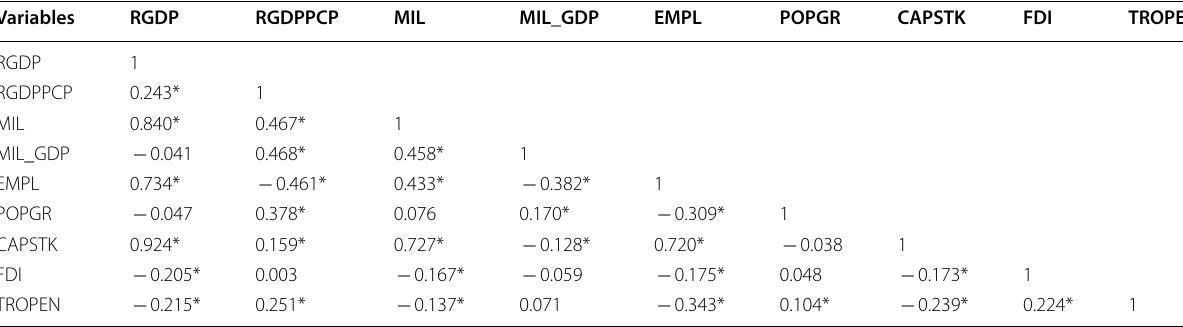
*Shows significance at the 0.05 level RGDP, RGDPPCP, MIL, MIL_GDP, EMPL, POPGR, CAPSTK, FDI and TROPEN denote real gross domestic product (M’USD), real gross domestic product per capita (M’USD), military expenditure (M’USD), military burden, employment (M), population growth (%), capital stock at a constant price, 2017 (M’USD), foreign direct investment